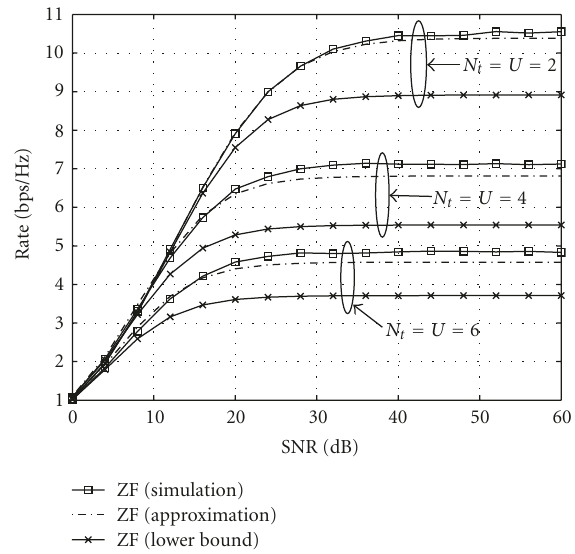
Figure 2: Comparison of approximation in (33), the lower bound in (29), and the simulation results for the ZF system with both delay and channel quantization. B = 10 bits, f c = 2GHz, v = 20 km/hr, and T s = 1msec.